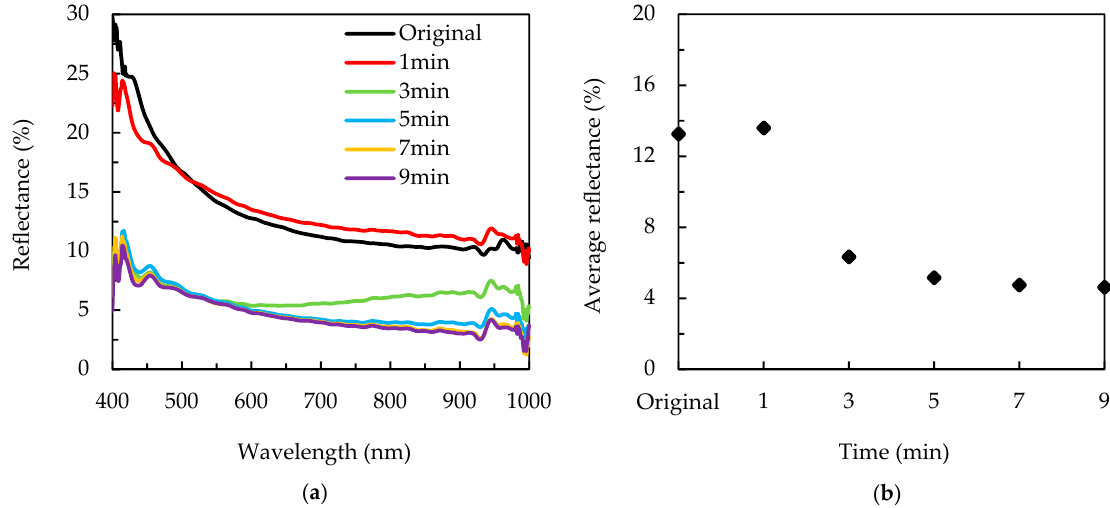
Figure 3. ( a ) Reflectance spectra and ( b ) average reflectance for the alkaline-etched silicon wafers with a different MACE time. The label “Original” refers to the sample with alkaline etching but without the MACE process.